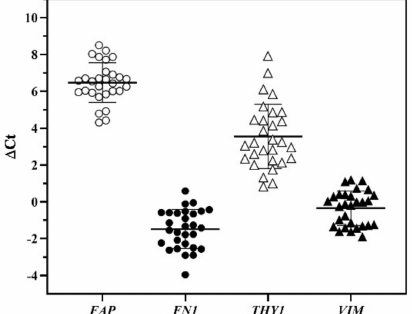
Figure 5. The expression of mRNA levels indicated by ∆ Ct values. The horizontal bars represent mean ± standard deviation from 29 cases. The symbols denote di ff erent genes. FAP : fibroblast activation protein; FN1 : fibronectin 1; THY1 : Thy-1 cell surface antigen; VIM :